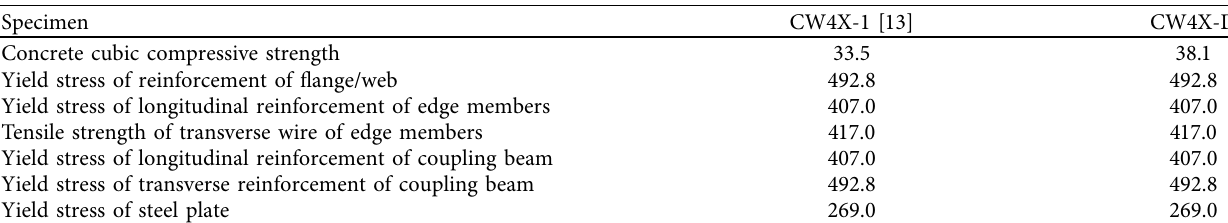
Figure 2: Details of steel-enhanced damping concrete core walls with concealed steel plate bracings (units: mm). (a) Inner frame. (b) Elevation. (c) Plan. Table 1: Material strength of core wall specimens (unit: